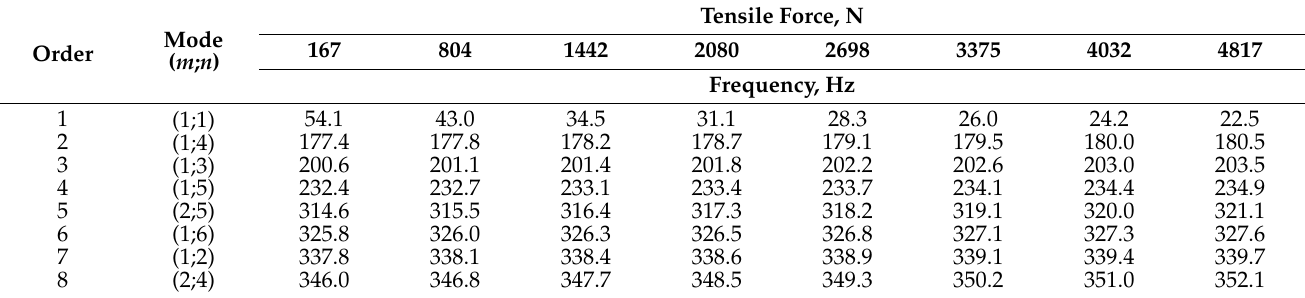
Table 3. The first numerical modes against the axial static load’s